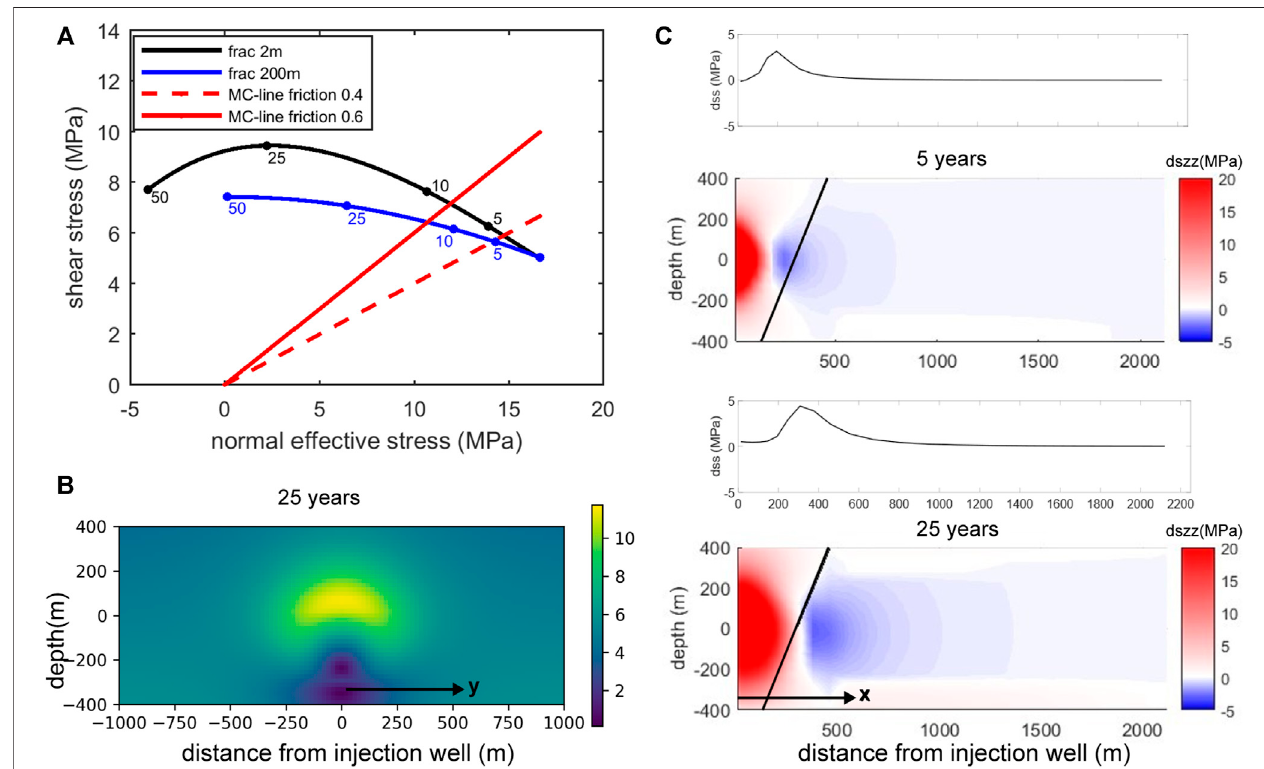
FIGURE5|(A) Stresspathatthefault,justbelowmid-heightreservoiratlocationy (cid:2) 0,forbothsmallandlargefracturespacing.Thefourcirclesonthestresspaths indicatestressconditionsat5,10,25,and50 yearsafteronsetofinjection. (B) Shearstressatthefaultplane.Verticalaxis:Mid-heightreservoirat0 m,unitsindepth(m) along dip. Location of projected injection well at y (cid:2) 0. (C) Arching of total vertical stress around the cooling rock volume, for 2 m fracture spacing. Contour plots represent a vertical cross section (x-direction) through the injection well, perpendicular to the fault plane. Contour plots show change in total vertical stress (dszz) after5and25 yearsofinjection.Mid-heightreservoirat0 m,unitsindepth(m)alongdip.Locationofprojectedinjectionwellatx (cid:2) 0.Notecompressivestress (cid:2) negative; hence positive value for dszz means total vertical stress decreases. Black solid line shows position of the fault. Small graphs above contour plots show change in shear stress dss, which affects stress path gradients in (A)